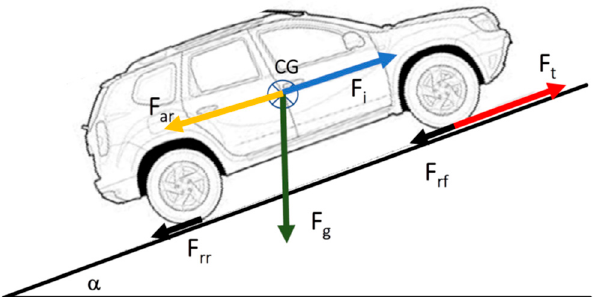
Figure 3. Forces acting on a moving vehicle ( F i , inertial force; F t , tractive force; F g , gravitational force; F rr , rear rolling resistance force; F rf , front rolling resistance force; F ar , aerodynamic (air) drag; CG, center of gravity; α , the road slope).